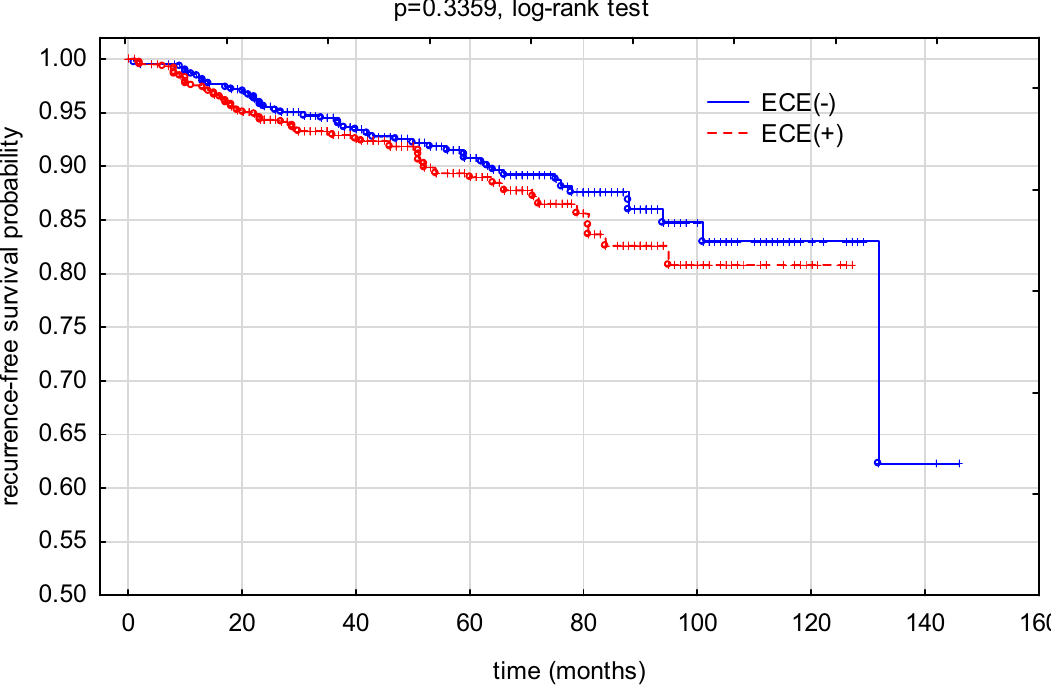
Figure 3. A recurrence-free survival probability (pRFS) rate in the analyzed group depending on the presence of